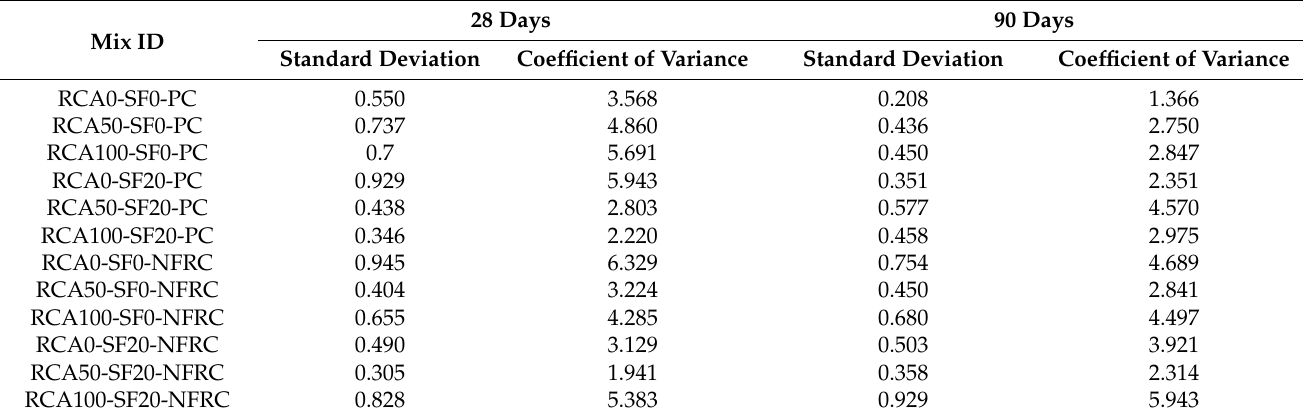
Table 8. Standard Deviation and Coefficient of Variation of Flexure Strength